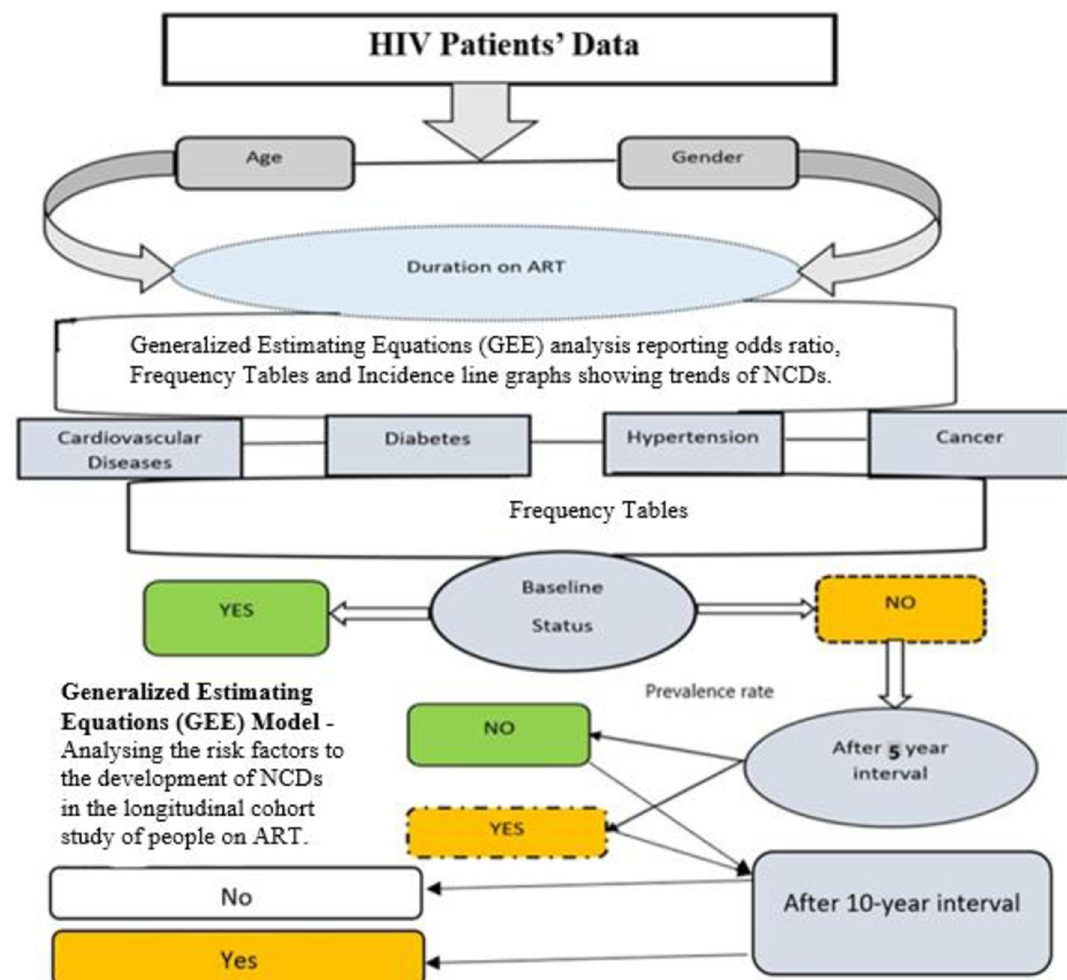
Fig 2. Methodology